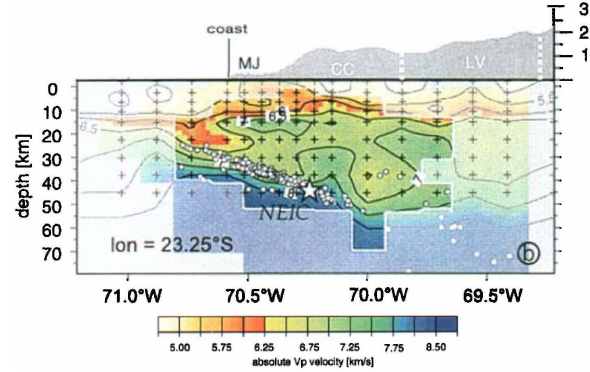
Figure 5: P-wave velocity tomography of Central Andes (Husen et al., 2000). The vertical section shows the presence of high P-wave velocity anomalies ( > 7.0 km/s) in the lower crust of the overriding South American plate. White circles are hypocenters. Star marks the hypocenter of the 1995 Antofagasta earthquake. Abbreviations: CC, Coastal Cordillera; LV, Longitudinal Valley; MJ, Mejillones Peninsula.